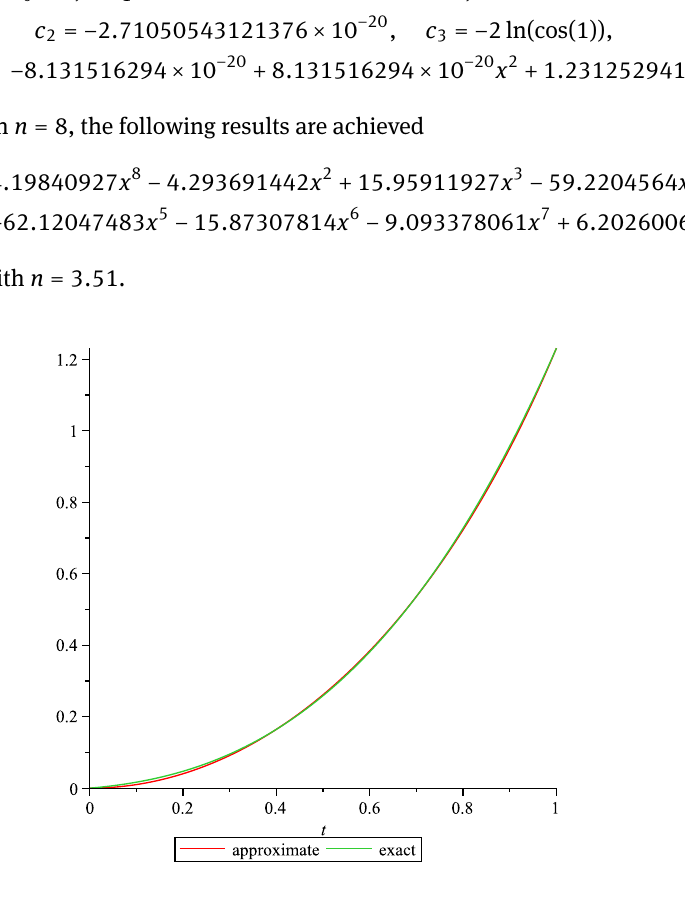
Figure 1: The graphs of approximated and exact solutions u ( x ) for Example